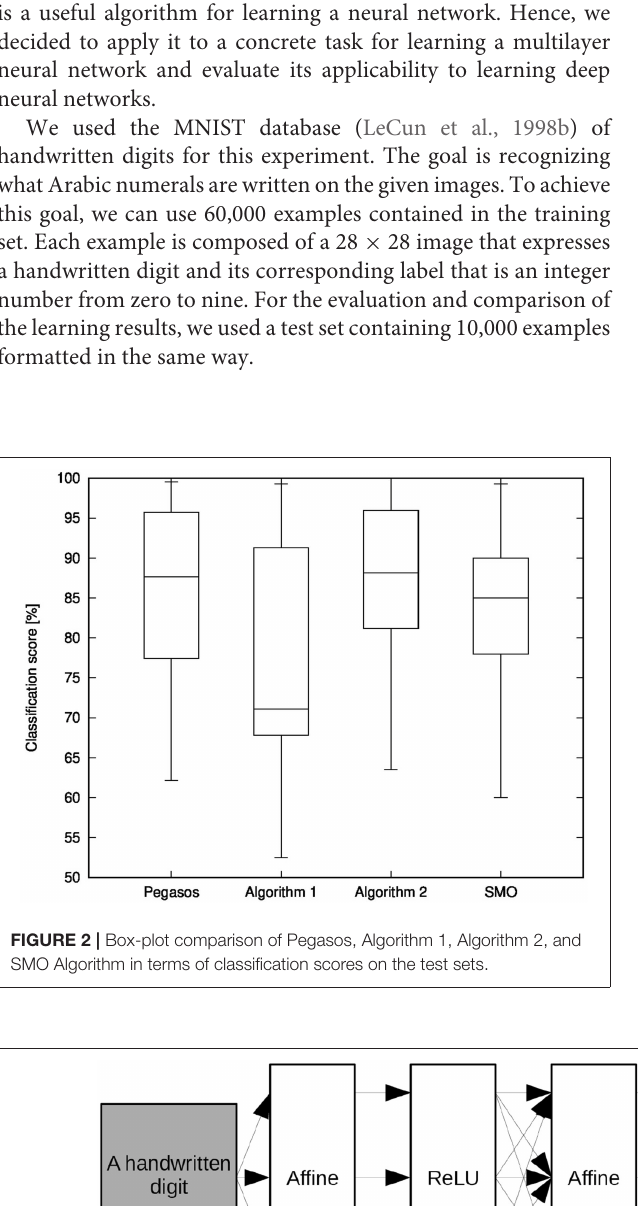
Frontiers in Robotics and AI |